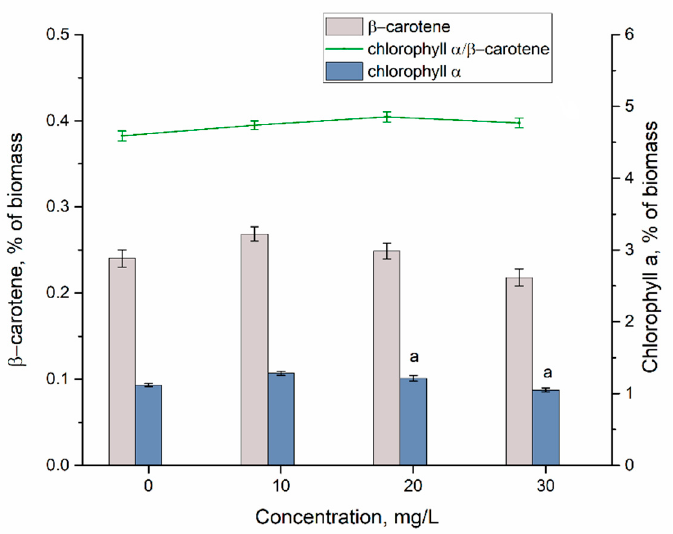
Figure 6. The content of pigments in the biomass of Arthrospira platensis exposed to Y(III) at a concentration of 10–30 mg/L (a— p < 0.01 for the difference between sample and control—chlorophyll).